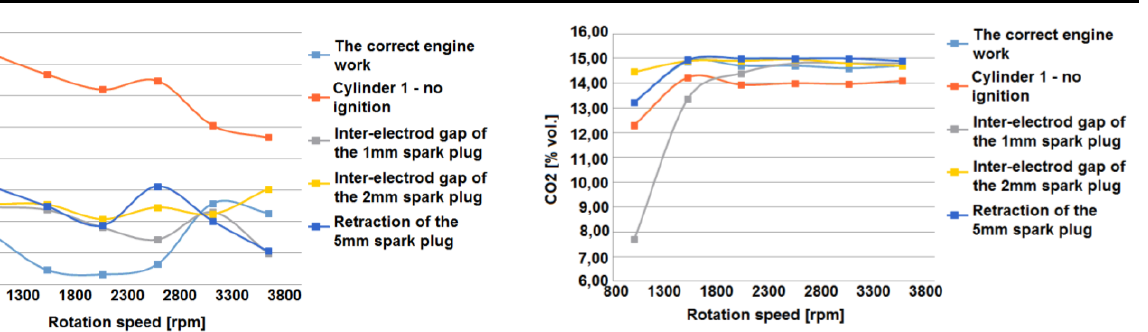
Fig. 18. The carbon dioxide content in the Fiat 1.1 engine exhaust gas Fig. 14. The oxygen content in the exhaust gas of the BMW M10B18 engine